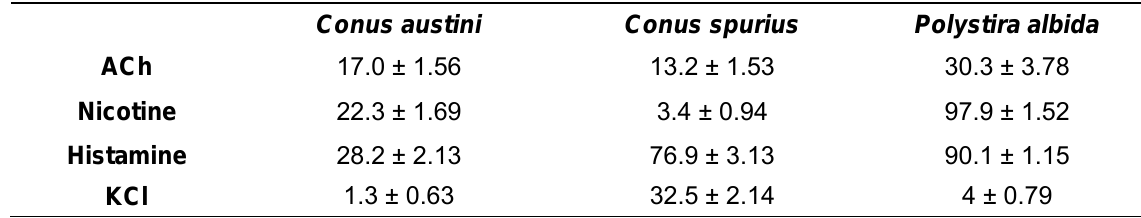
Table 2. Extract effects of the venom ducts obtained from C. austini , C. spurius and P. albida on contractions elicited by ACh (1 µM), nicotine (10 µM), histamine (0.5 µM) and KCl (60 mM)